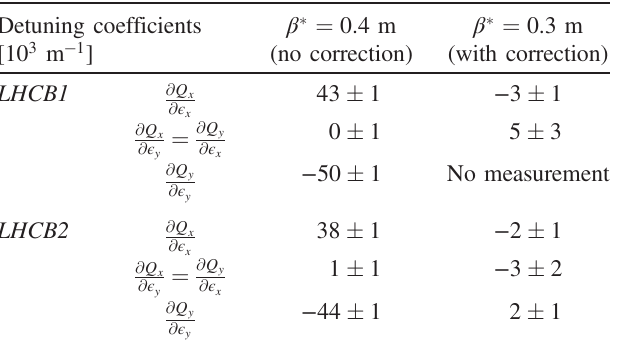
TABLE II. Amplitude detuning coefficients at β (cid:1) ¼ 0 . 4 m without normal octupole correction, and at β (cid:1) ¼ 0 . 3 m after correction.